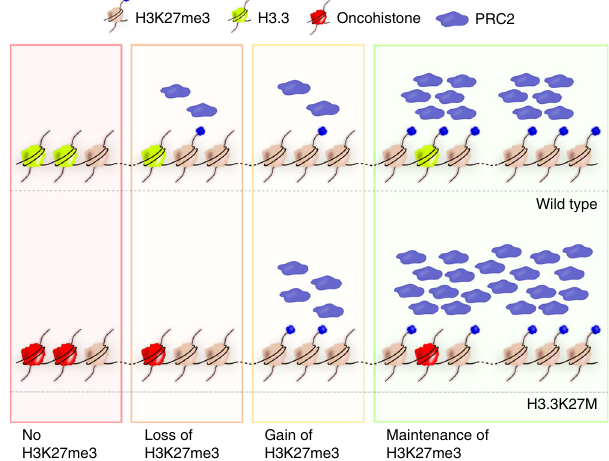
Fig. 7 Model for local, concentration-dependent inhibition of PRC2 by H3.3K27M oncohistones. Incorporation of oncohistones locally disrupts the positive regulatory feedback loop between existing H3K27me3 and